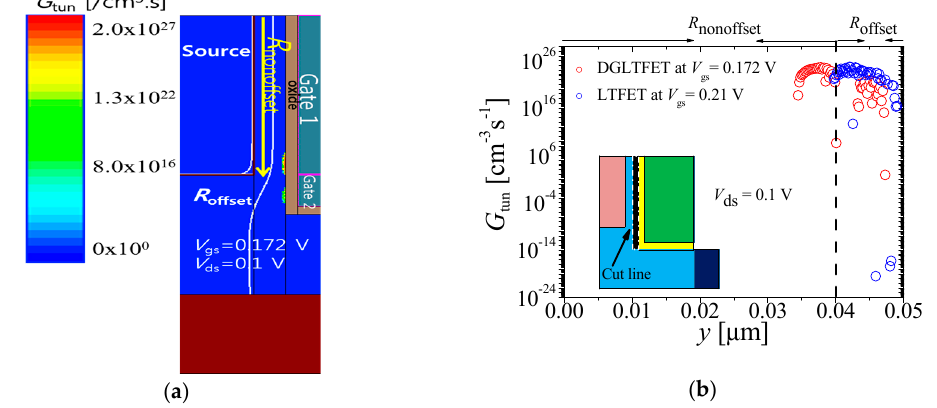
Figure 7. ( a ) G tun contour plot of DG-LTFET at V gs = 0.172 V, which is needed to generate I ds = 10 − 13 A and ( b ) G tun extracted from ( a ) (red symbols). Also shown for reference is G tun (blue symbols) of the LTFET at a V gs bias needed to generate I ds = 10 − 13 A. In ( a ), yellow arrow indicates the height of R nonoffset .